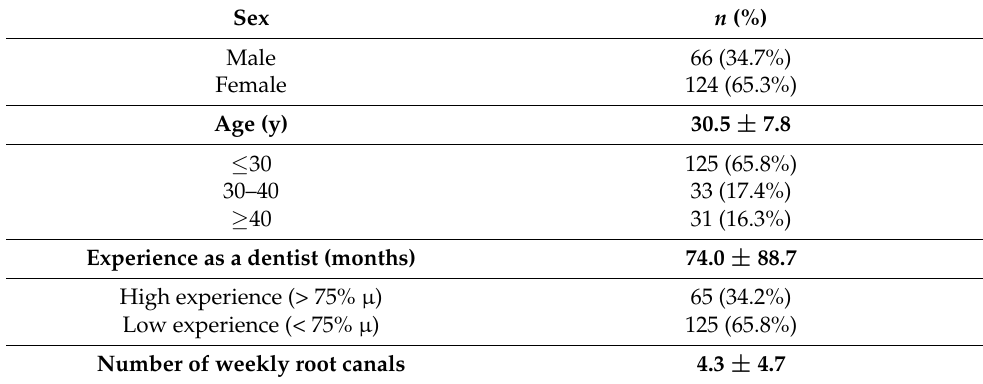
Table 1. Description of participants.